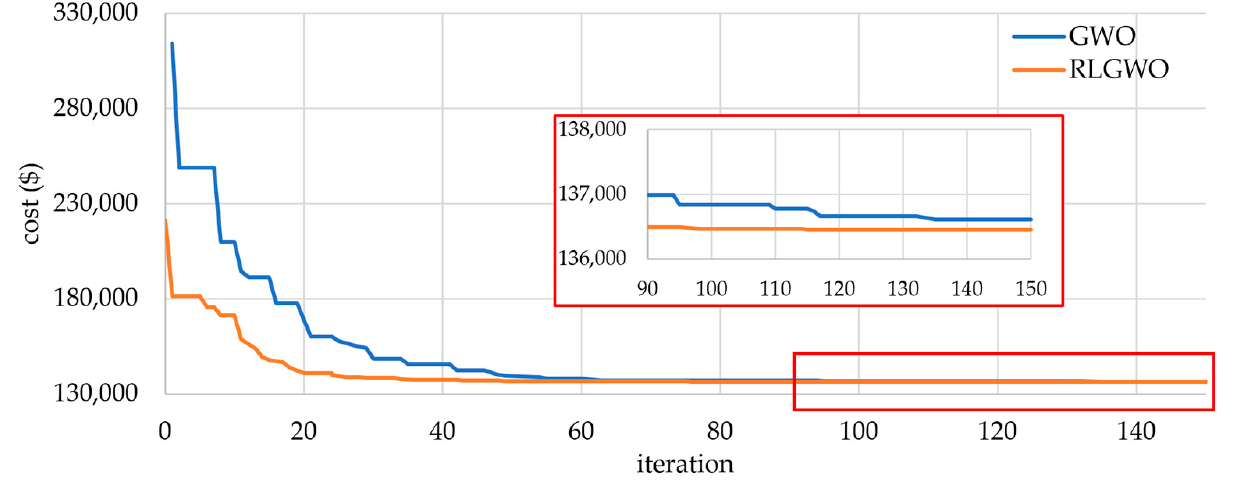
Figure 6. Comparative convergence characteristics of the original GWO and the proposed RLGWO algorithms for the 40-unit system. Table 4. Comparison between different methods taken after 50 trials (40-unit system with loss). (cid:3404) 10500𝑀𝑊 ). Table 3. Best simulation results for the 40 ‐ unit system with loss ( 𝑃 (cid:3005) Generation Costs Time (s) Method